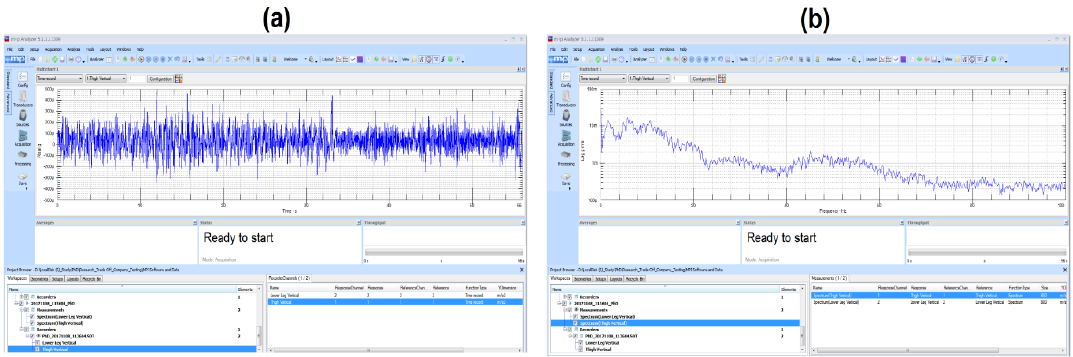
Figure 8. Test set up: ( a ) standard laptop with the signal processing tool “m+p Analyzer”, ( b ) NI 9234 module for measurement, and ( c ) Dytran 3055 sensor mounted on human driver thigh.